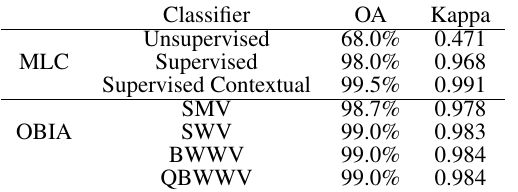
Table 4. Overall accuracy and Coen’s Kappa for different classifiers after strings and lines removal. OA: Overall accuracy. MLC: Maximum Likehood Classification.